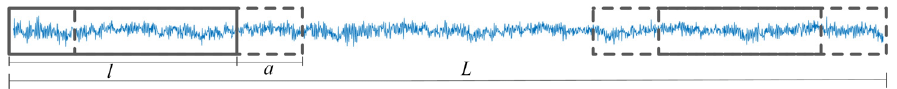
Figure 6. Data overlap sampling process.